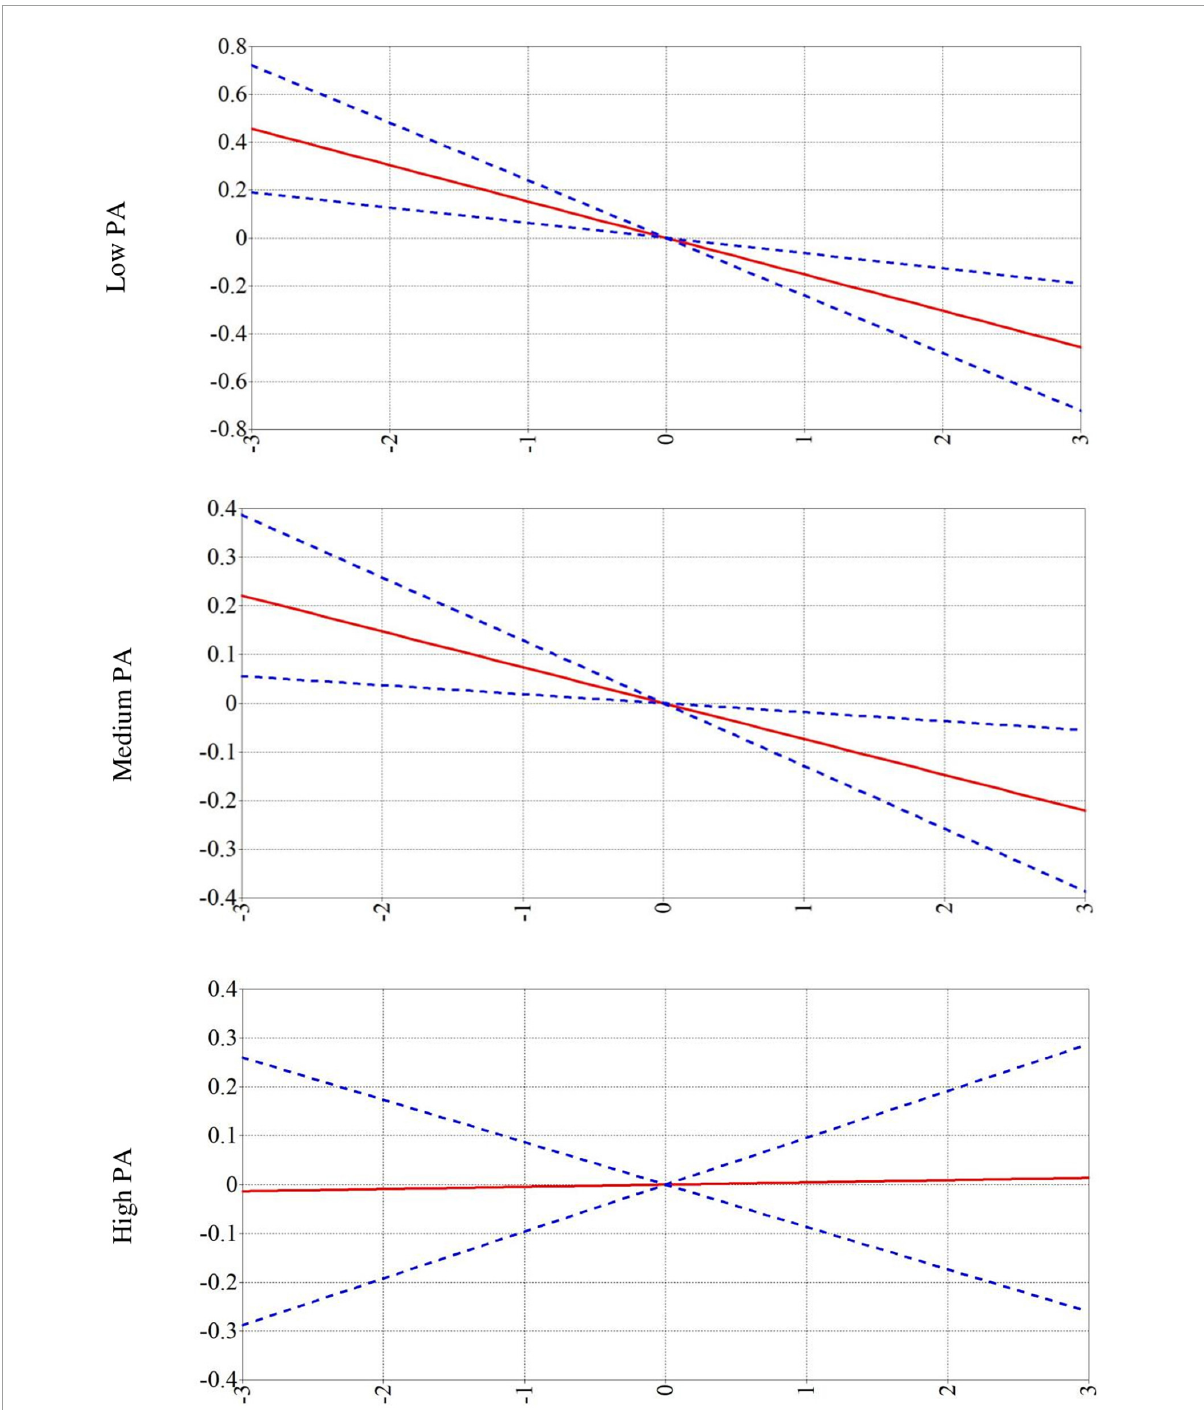
FIGURE3 Effects of television viewing (TV) on Woodcock Johnson (WJ) latent variable scores moderated by physical activity (PA). Blue dotted line is the 95% confidence interval and red line is the trend line of the means. The X axis for all three figures is TV viewing, and the Y axis is WJ scores.